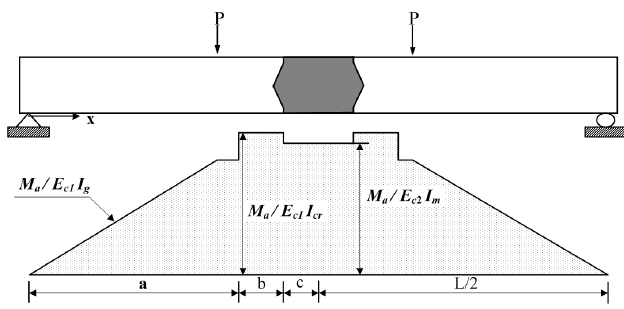
Figure 7. Proposed curvature diagram of the modular specimen.